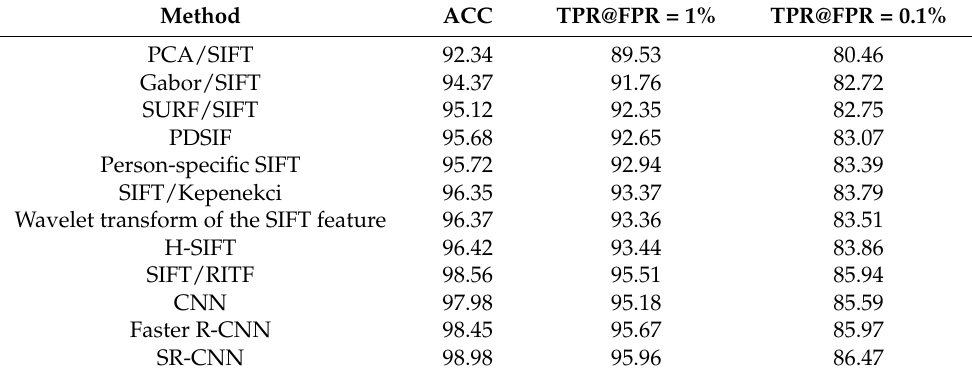
Table 2. Recognition performance of different improved the scale-invariant feature transform (SIFT) models using the LFW dataset. ACC—recognition accuracy rate; TPR—true positive rate; FPR—false positive rate; PCA—principal component analysis; SURF—speeded up robust features; PD—partial descriptor; H—hexagonal; RITF—rotation-invariant texture feature; R-CNN—region-based CNN; SR-CNN—CNN with SIFT and